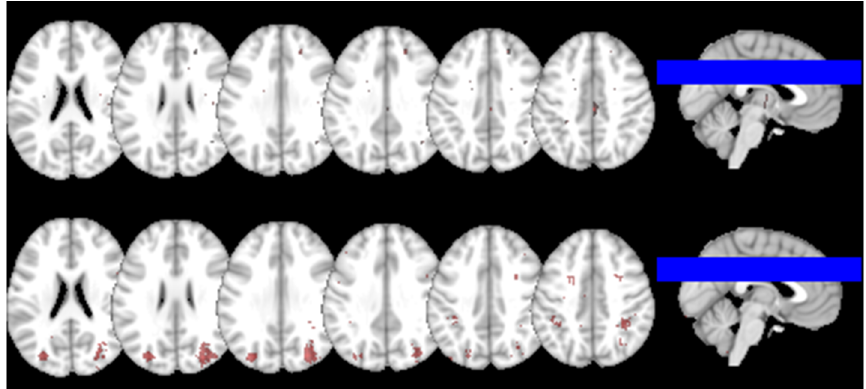
Figure 3. Probability Distribution Map of the BMBs in this sample (above) and Reverse Inference Map of the brain regions that were preferentially related to the term visuospatial in the 224 studies (below). The locations that show the red-to-white foci appear to be reported more often in articles that include the term visuospatial in their abstracts than in articles that do not.